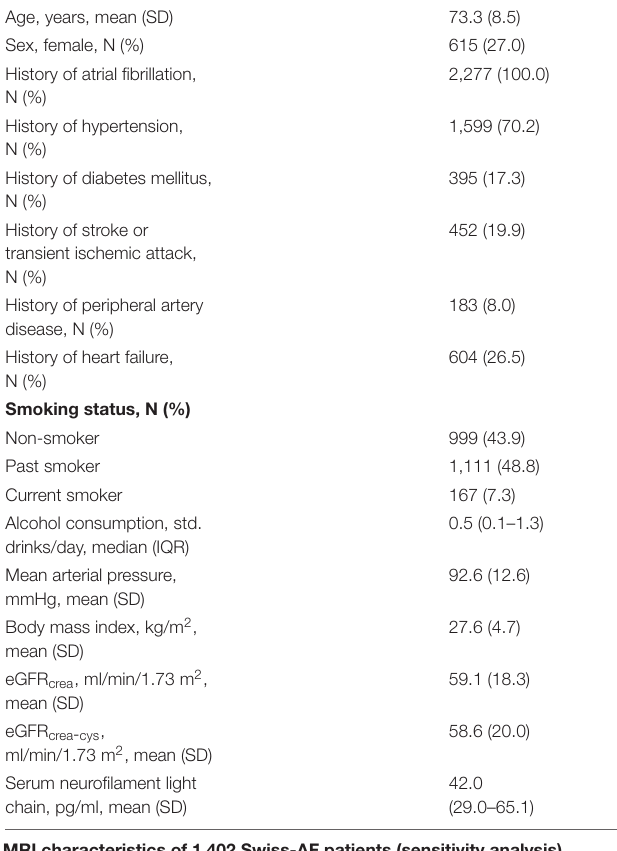
TABLE 1 | Patient